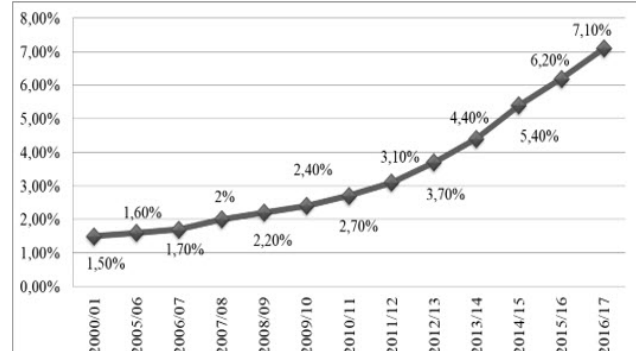
Figure 4. The ratio of foreign students to the total number of students in RF universities (2000 – 2017),